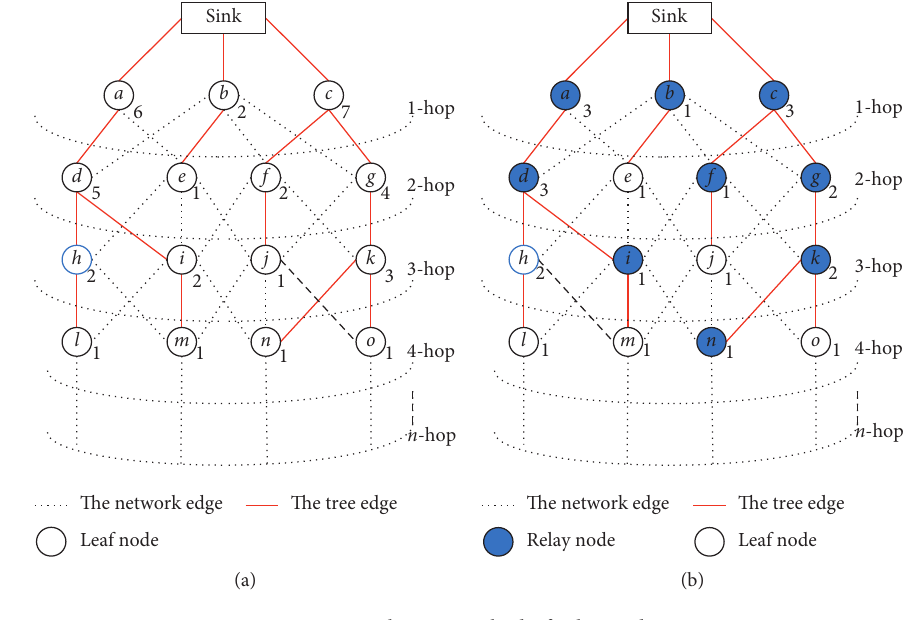
Figure 2: Selecting method of relay